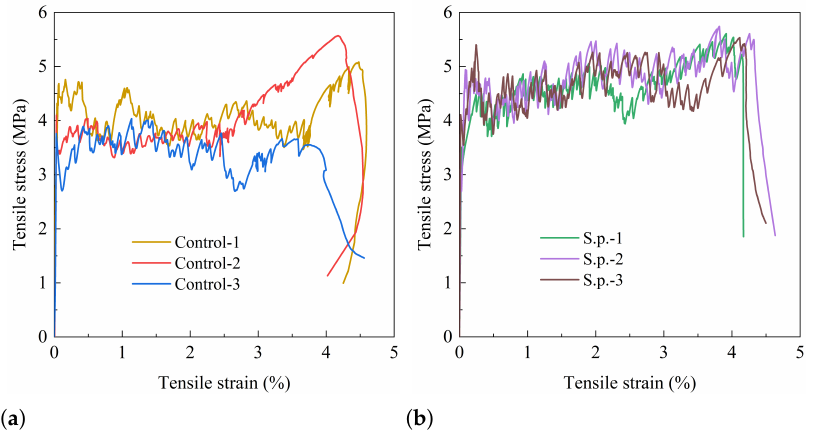
Figure 11. Tensile stress-strain experimental curve of ECC. ( a ) Without bacteria. ( b ) With